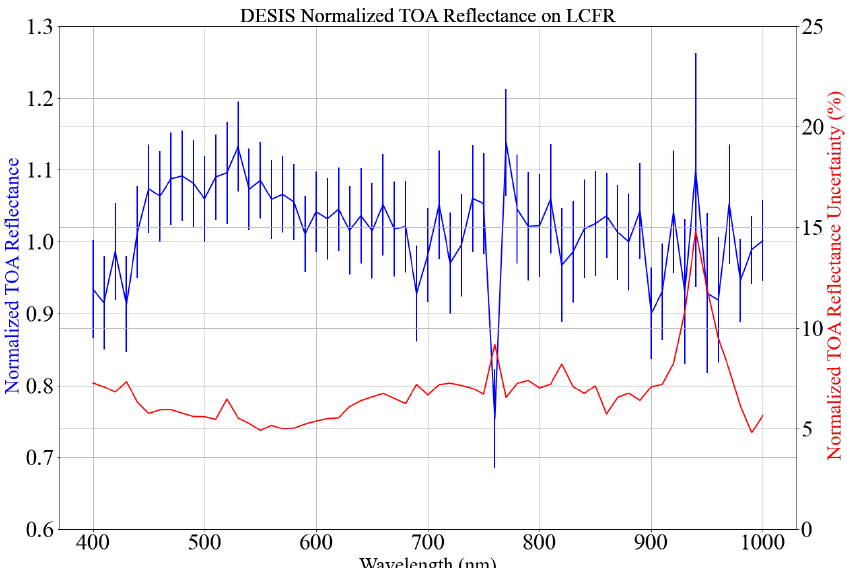
Figure 16. Mean and standard deviation of 6 normalized DESIS TOA reflectance shown in Figure 15a.